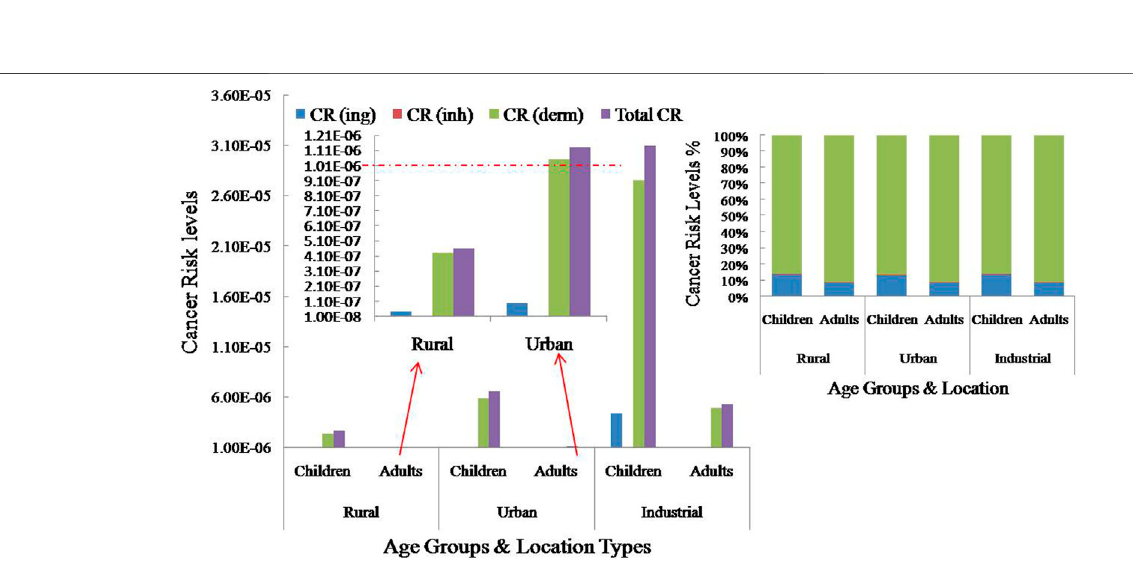
Frontiers in Environmental Science |